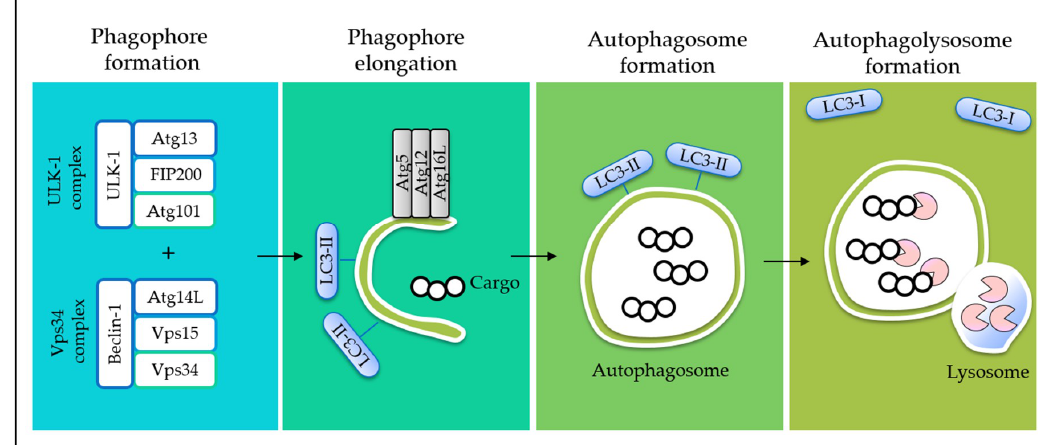
Figure 2. The process of autophagy. During autophagy, phagophore (cup-shaped, double-membrane sac) emerges in cytoplasm, driven by unc-51-like kinase 1 (ULK1) complex and vacuolar protein sorting (Vps) 34 complex. The expansion of phagophore is facilitated by Atg5–12/Atg16L complex to uptake cargos from the cytoplasm into a double-membrane autophagosome. The loaded autophagosome then fuses with lysosome to allow the degradation of cargo by lysosomal proteases, while microtubule-associated protein light chain 3 (LC3-I) will be recycled back to cytosol. The endogenous LC3-I, present in the cytoplasm, is processed to LC3-II and bound to the autophagosome during autophagy. Therefore, the ratio of LC3-I (water soluble) and LC3-II (lipidated) is often used as a marker to assess autophagy. Then, the lysosomal permeases and transporters export amino acids and other by-products of degradation back to the cytoplasm, where they can be reused for building macromolecules and for metabolism [37]. Abbreviations: Atg, autophagy-related protein; FIP200, focal adhesion kinase family interacting protein of 200 kDa.